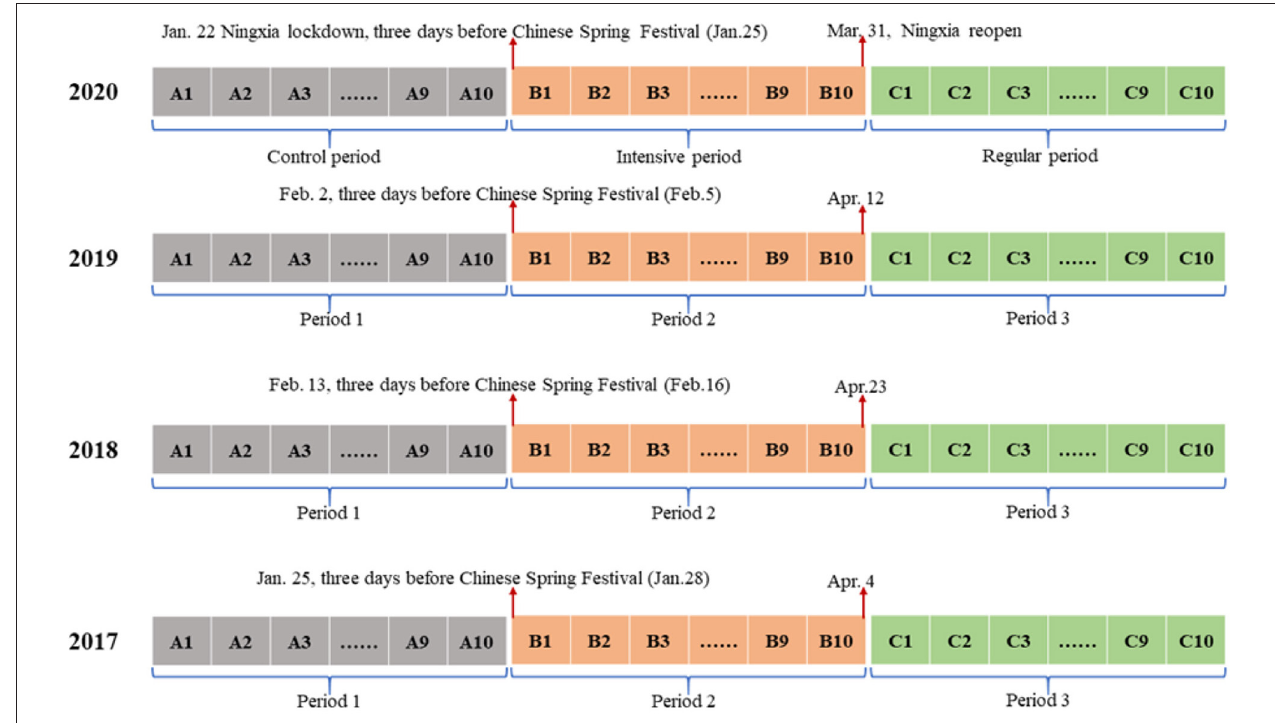
FIGURE 2 | Key time points of three periods based on responses related to COVID-19 in the Ningxia Hui Autonomous